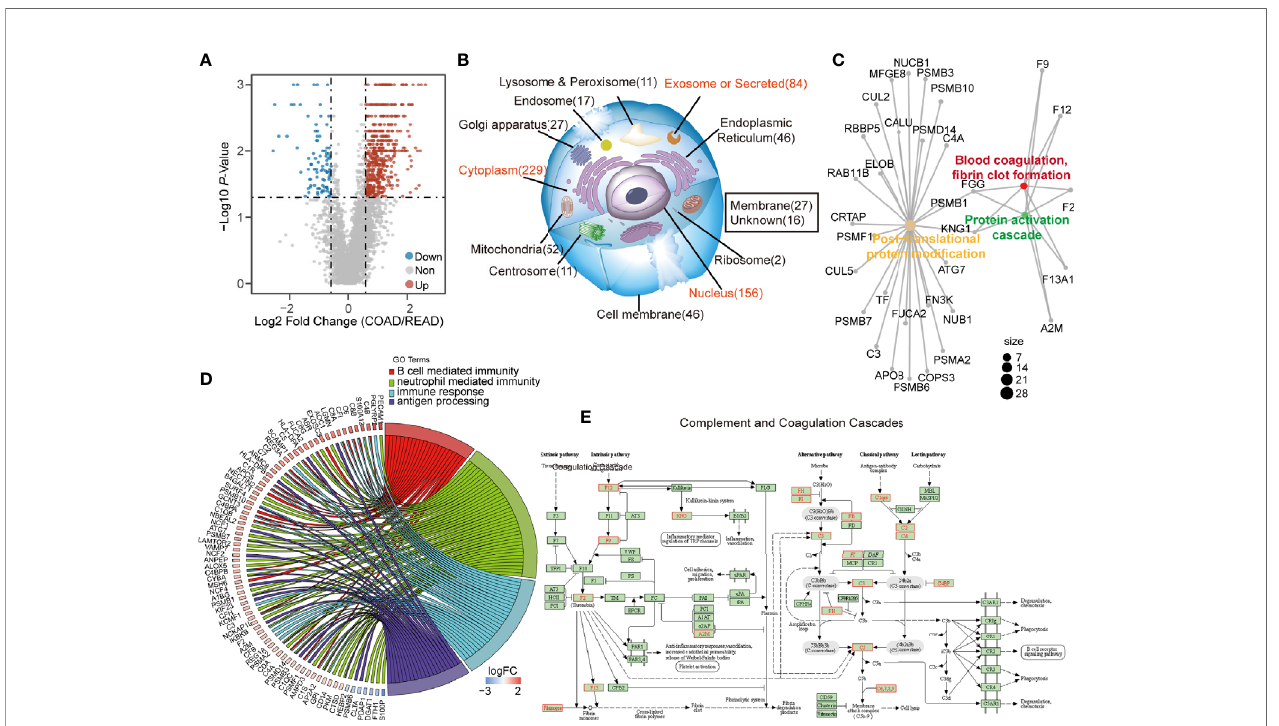
FIGURE 2 | The differential expressed proteins (DEPs) between colon adenocarcinoma (COAD) and rectal adenocarcinoma (READ) enriched in immune activation. (A) The volcano graph described 534 up-regulated proteins and 92 down-regulated proteins in COAD. (B, C) The DEPs were subjected to subcellular location enrichment analysis and biological pathway enrichment analysis, showing the DEPs were mainly located to secreted proteins, and relevant to the biological progress of PTM, protein activation cascade and blood coagulation, fi brin clot formation. (D) The biological pathway enrichment analysis also showed that four immune- relevant pathways including antigen processing and presentation of exogenous peptide antigen, humoral immune response, neutrophil mediated immunity, B cell mediated immunity were upregulated in COAD. (E) Kyoto Encyclopedia of Genes and Genomes (KEGG) analysis showing the pathway of complement and coagulation cascade. The identi fi ed upregulated proteins in COAD compared to READ were labeled as red, while the downregulated proteins were showed in